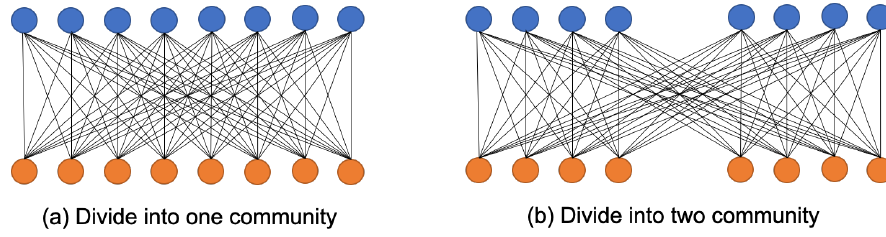
Figure 5. When u = 4 and V = 4, the complete bipartite graph (CBG) is divided according to R1 and